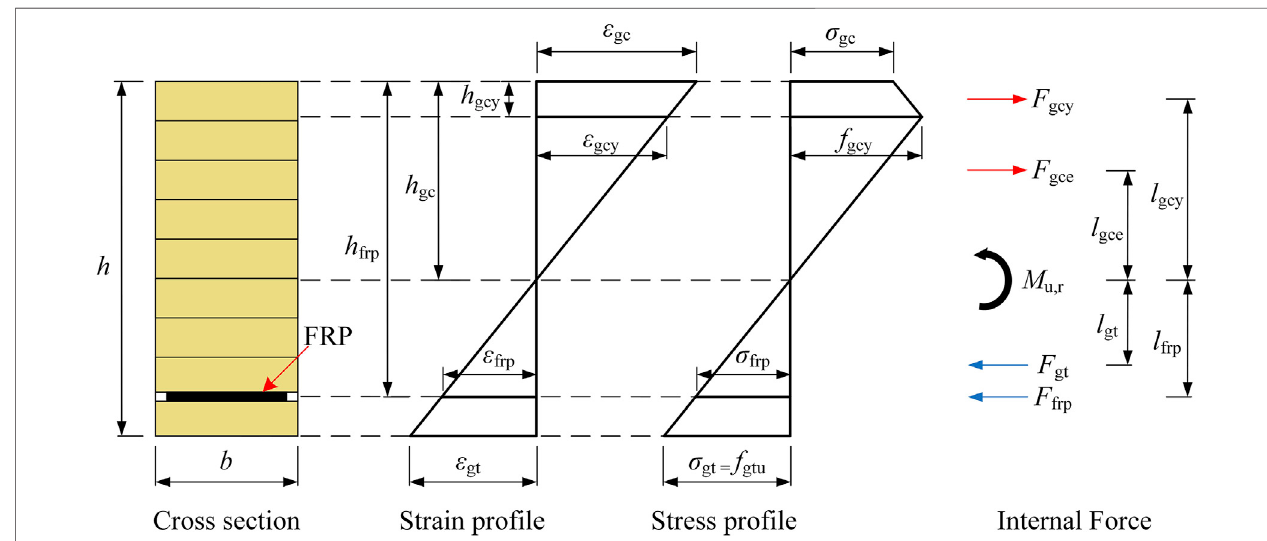
FIGURE 12 | Theoretical model for predicting the M u of the reinforced glulam beams.